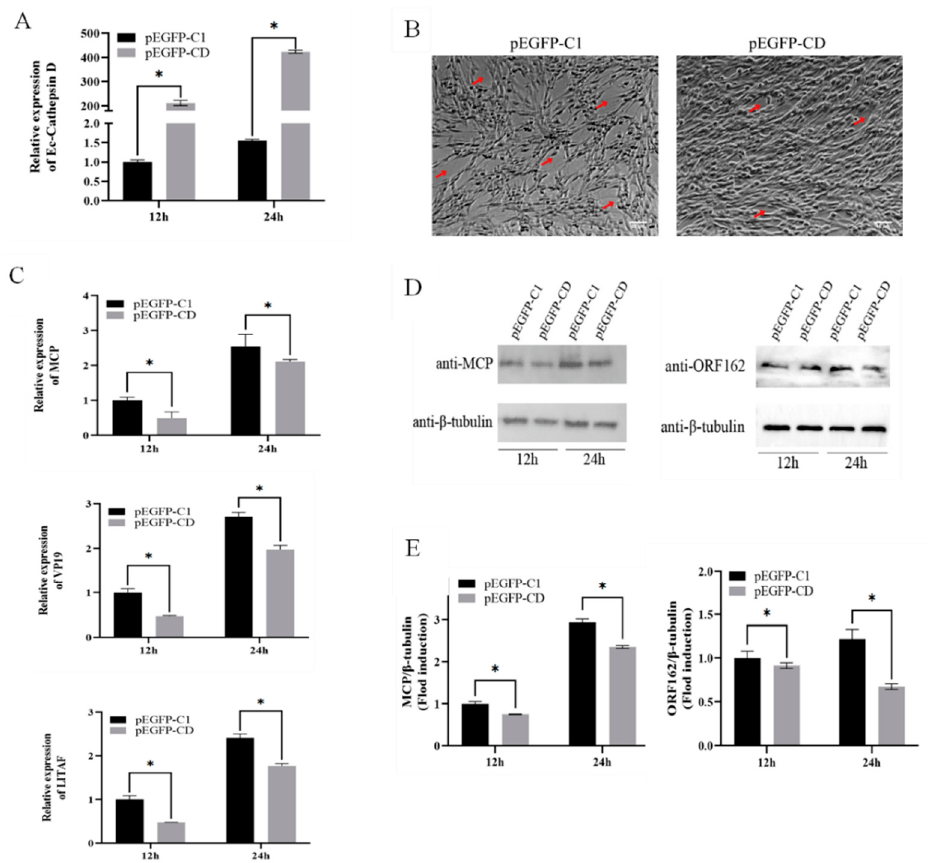
Figure 2. Overexpression of Ec-CD significantly inhibited SGIV infection. Cells were infected with SGIV after being transfected with pEGFP-C1 and pEGFP-CD 24 h later. ( A ) The relative expression of Ec-CD was evaluated by qRT-PCR. ( B ) The severity of CPE induced by SGIV was weakened. ( C ) The relative expressions of SGIV-MCP, SGIV-VP19 and SGIV-LITAF genes after SGIV infection were evaluated by qRT-PCR. The relative expression ratio of the selected gene vs. β -actin (reference gene) was calculated using the 2 − ∆∆ Ct method. ( D ) SGIV-MCP protein SGIV-ORF162 protein and cellular β -tubulin were analyzed by WB, and MCP/ β -tubulin, ORF162/ β -tubulin for each group were calculated as above. ( E ). Data are means ± SD from four experiments. Student’s t -test: * p <